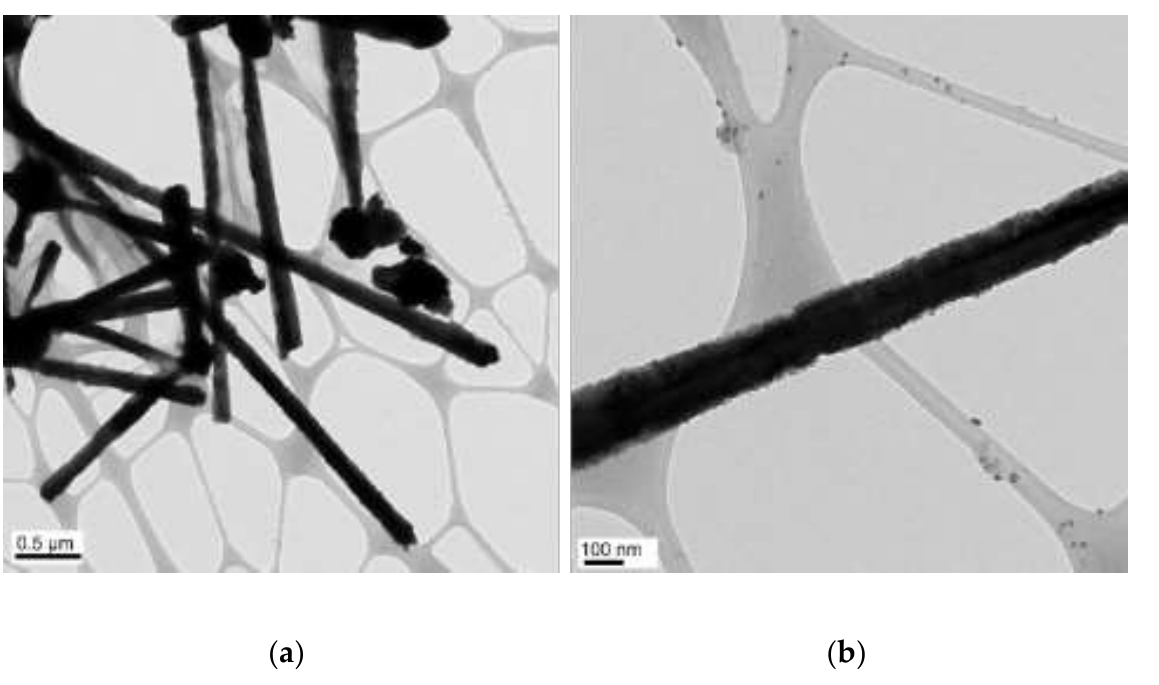
Figure 10. TEM images of copper nanowires with 50 µL of EDA: ( a ) scale bar 0.5 µm; ( b ) scale bar 100 nm. Table 3. Dimensions of copper nanowires synthesized under various amounts of EDA.